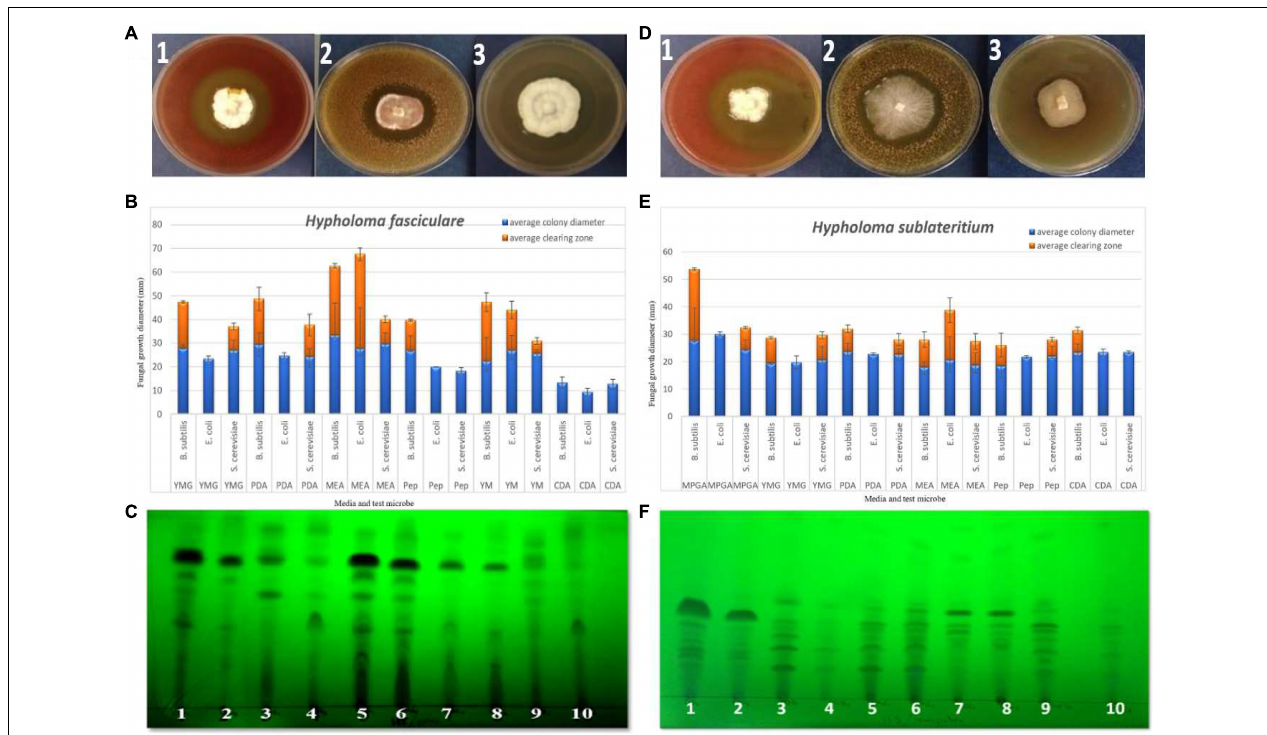
FIGURE 1 | (A,D) Examples of the zone inhibition plates of Hypholoma fasciculare and Hypholoma sublateritium showing the clearing zone around the fungal colony, indicating the antimicrobial activity of these fungi against Bacillus subtilis (1), Saccharomyces cerevisiae (2), and Escherichia coli (3), respectively. (B) Zone inhibition assay to evaluate the antimicrobial activity of H. fasciculare growing on different media against B. subtilis , E. coli , and S. cerevisiae . Error bars indicate the standard deviations of three technical replicate measurements for both fungal colony diameter (column in blue ) and inhibition zone diameter (column in red ). (E) Zone inhibition assay of H. sublateritium growing on different media against B. subtilis , E. coli , and S. cerevisiae . Error bars indicate the standard deviations of three technical replicate measurements. (C,F) Thin-layer chromatography (TLC) plates developed in a polar ( H. fasciculare ) and a semi-polar ( H. sublateritium ) system and visualized under UV 320 nm showing the separated compounds of H. fasciculare . Twenty-five microliters of 10 mg/ml crude extract of H. fasciculare from five different media was spotted. 1 = CSO supernatant extract; 2 = CSO mycelial extract; 3 = PDB supernatant extract; 4 = PDB mycelial extract; 5 = YMG supernatant extract; 6 = YMG mycelial extract; 7 = CGC supernatant extract; 8 = CGC mycelial extract; 9 = MEB supernatant extract; 10 = MEB mycelial extract. YMG , yeast extract malt; PDB , potato dextrose broth; PDA , potato dextrose agar; MEA , malt extract agar; Pep , peptone agar; YM , yeast malt extract; CDA , Czapek Dox agar; MPGA , malt peptone glucose